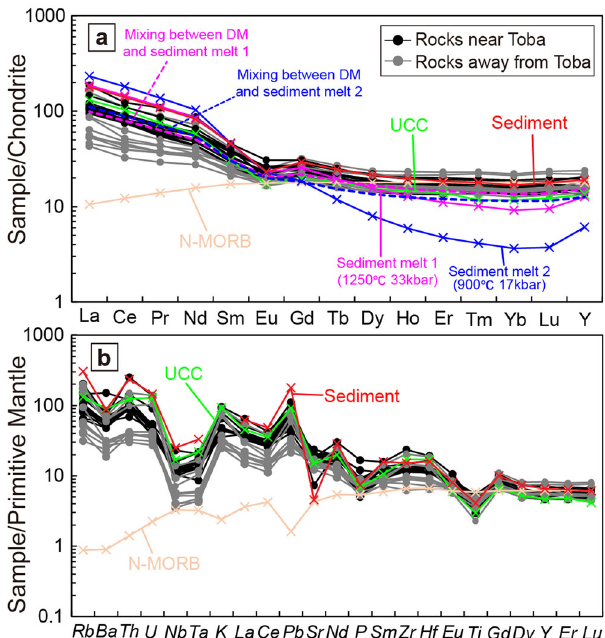
Fig. 2 Trace element characteristics of the arc volcanic rocks in northern Sumatra. a Chondrite-normalized rare earth element (REE) patterns of the studied rocks. b Primitive mantle-normalized trace element spider diagram of the studied rocks. Trace element and REE compositions of the N-MORB 86 , upper continental crust (UCC; ref. 87 ), and subducted sediments 6 are also shown for comparison. Calculated REE concentrations of the sediment melt at 1250 °C, 33 kbar (Sediment melt 1) and 900 °C, 17 kbar (Sediment melt 2) are shown in a . Mixing of DM (composition represented by N-MORB) with 50% sediment melt 1 and with 45 % sediment melt 2 can produce the REE patterns observed in rocks near Toba in a